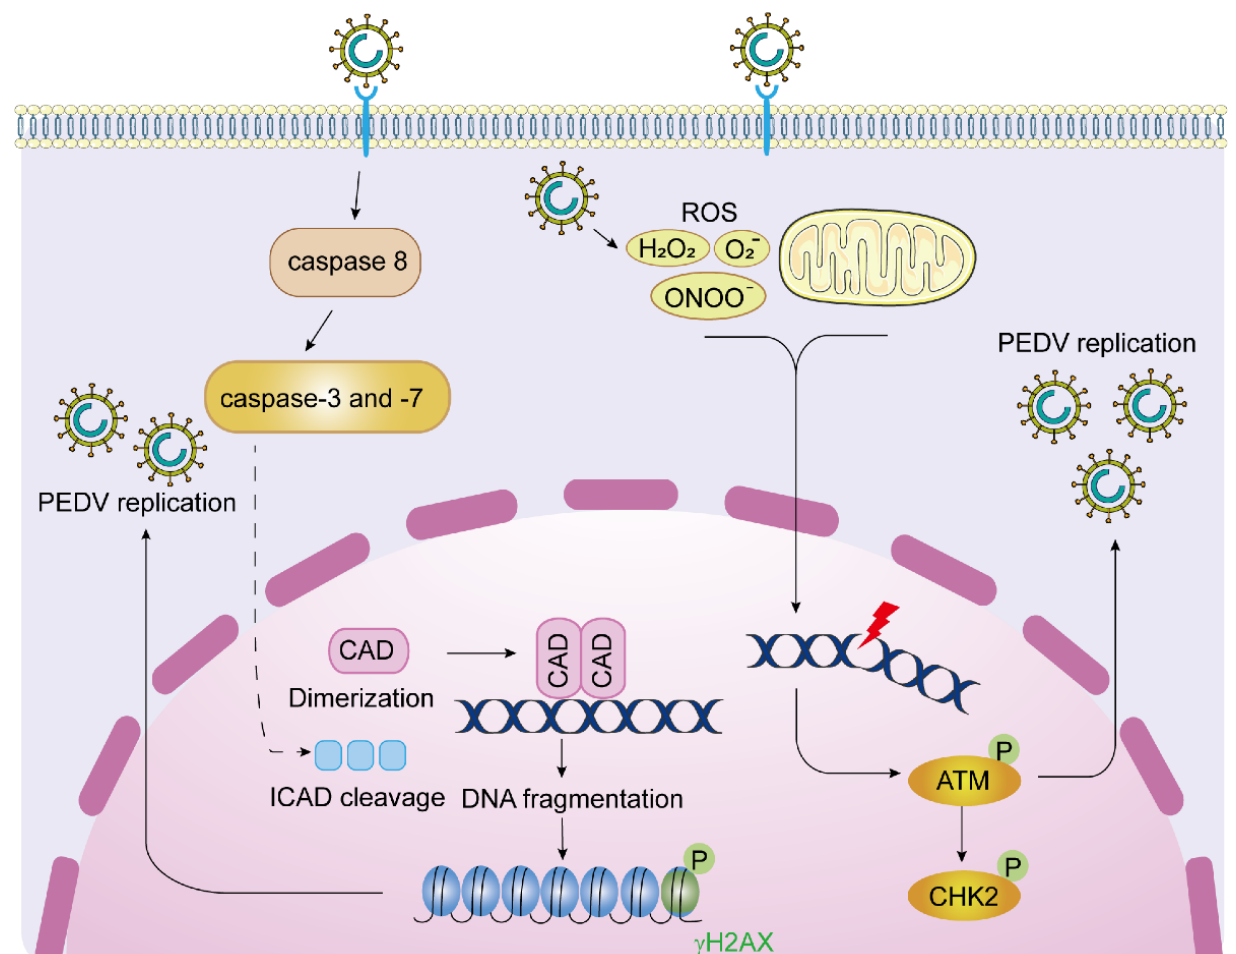
Figure 8. The interplay between PEDV replication and cellular DNA damage response. After PEDV enters host cells and replicates in the cytoplasm, the accumulation of massive intracellular ROS activates ATM-mediated DSB. Activated ATM and its downstream substrate Chk2 facilitate viral replication in the early infection stage. In the late stage of PEDV infection, the initiator caspase-8 activates the executioner caspase-3 and caspase-7 which subsequently cleave ICAD and release CAD from the ICAD-CAD complex and promote the homodimerization of CAD. The scissor-like CAD dimers create DSBs in the genome and DNA fragmentation, leading to H2AX phosphorylation in the nucleus. Inhibition of H2AX, ATM, and Chk2 dampens the replication of PEDV. APO and DPI are NADPH oxidase inhibitors. NAC is a synthetic precursor of cys- teine and glutathione and functions as a ROS scavenger. These inhibitors are applied in numerous studies to suppress oxidative stress, but the mechanisms of their activities are unclear. Surprisingly, our data suggested that only APO sufficiently decreased ROS,